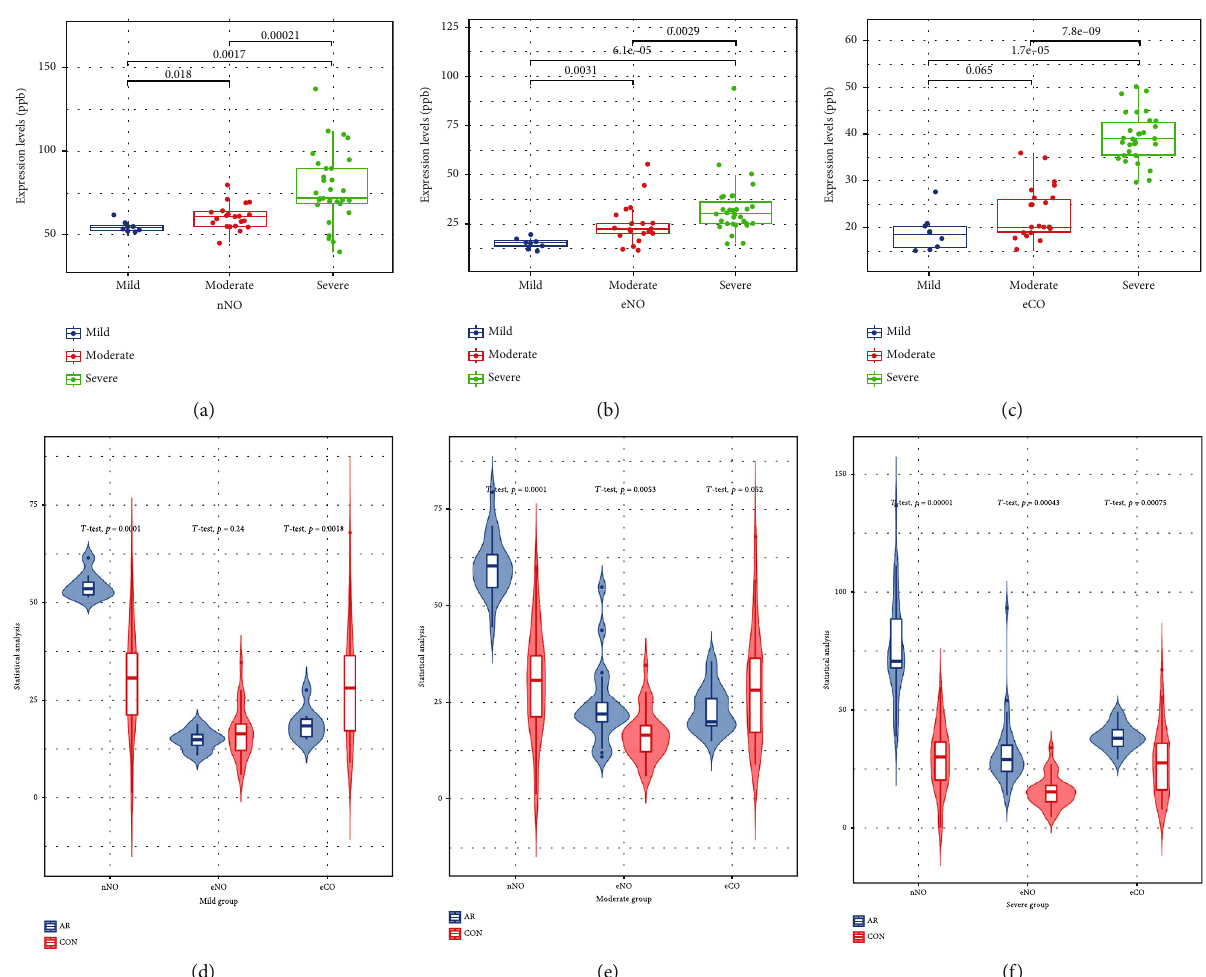
Figure 2: The levels of nNO, eNO, and eCO in the three subgroups of AR were higher than those in the control group, and the di ff erences were statistically signi fi cant except for eNO in mild AR group ( p = 0 : 24 ) and eCO in moderate AR group ( p = 0 : 052